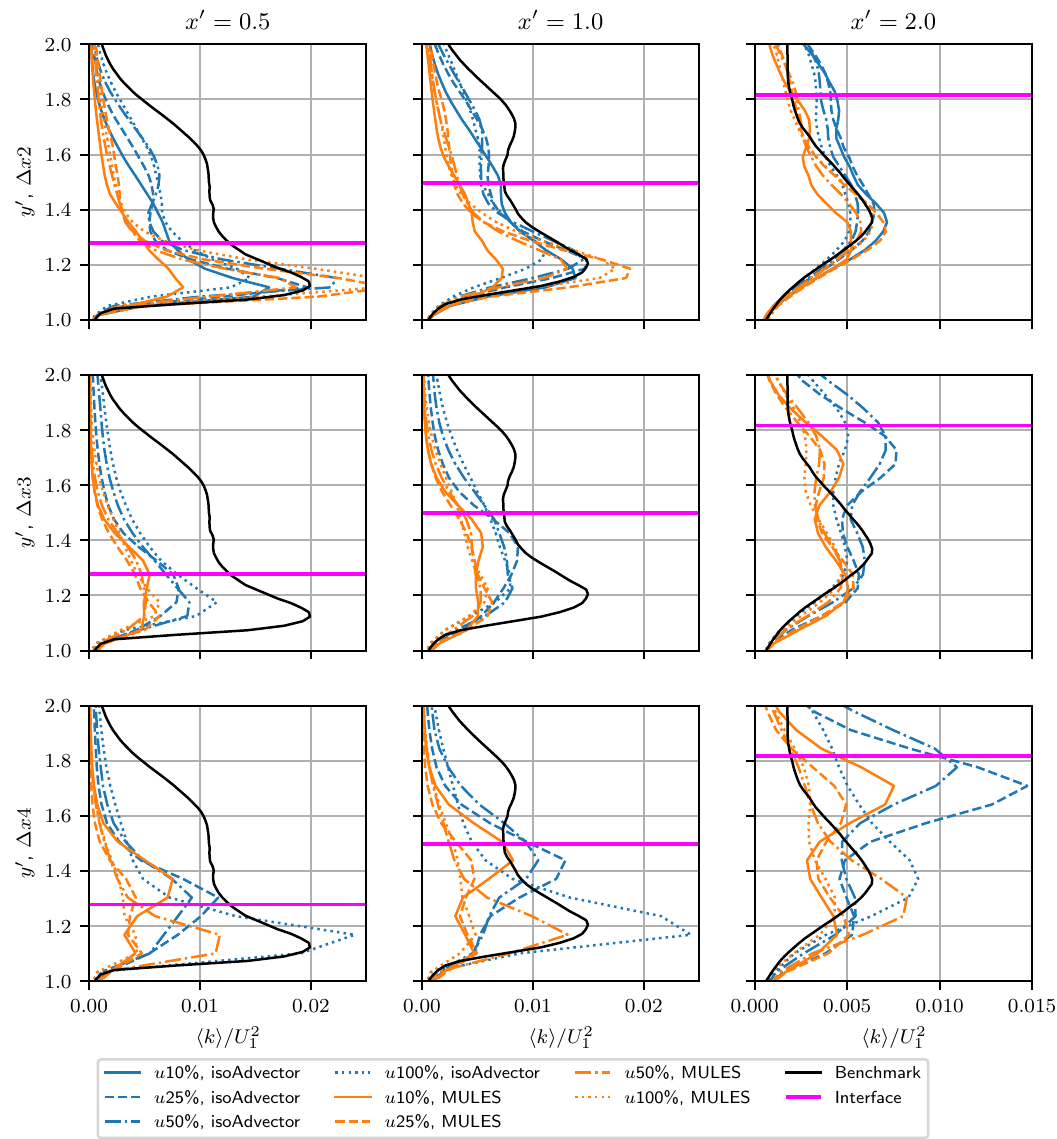
Figure 13. The profiles of (cid:104) k (cid:105) / U 2 obtained in the simulation campaign. 1 Finally, the periodicity of air entrainment was analysed. As for the benchmark sim- ulation, the autocorrelation functions of the volume of air passing through a box located some distance downstream of the toe (see the top-left plot in Figure 3) were computed. The results are shown in Figure 15. For ∆ x 2 and ∆ x 3, the location of the first peak was quite well predicted by all the simulations, whereas for ∆ x 4, the accuracy deteriorated, in particular for some of the simulations using MULES. Animations of the α = 0.5 isosurface revealed that isoAdvector did a much better job at preserving the sharpness of the interface as the entrained bubbles travelled downstream. Therefore, if tracking the fate of the bubbles is important, using this VoF approach is recommended. It should also be noted that while all the simulation predicted similar entrainment frequencies, other statistical air entrainment properties did not agree equally well. For example, the mean amount of air within the monitored box was highly affected by the choice of the VoF method, with MULES giving systematically higher